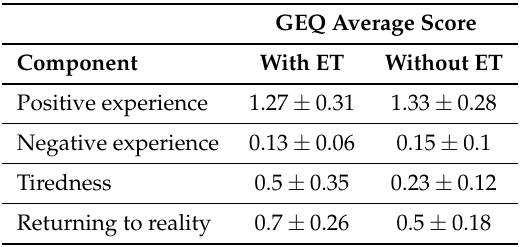
Table 3. Average values for the different components on the GEQ post-game module for the play sessions with and without Eye Tracking (ET). Results provided as STD ± STE, where STD stands for standard deviation and STE for standard error of the